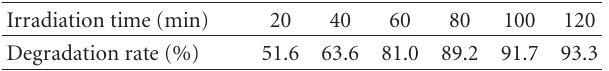
Table 1: E ff ect of irradiation time on the degradation of naphtha-